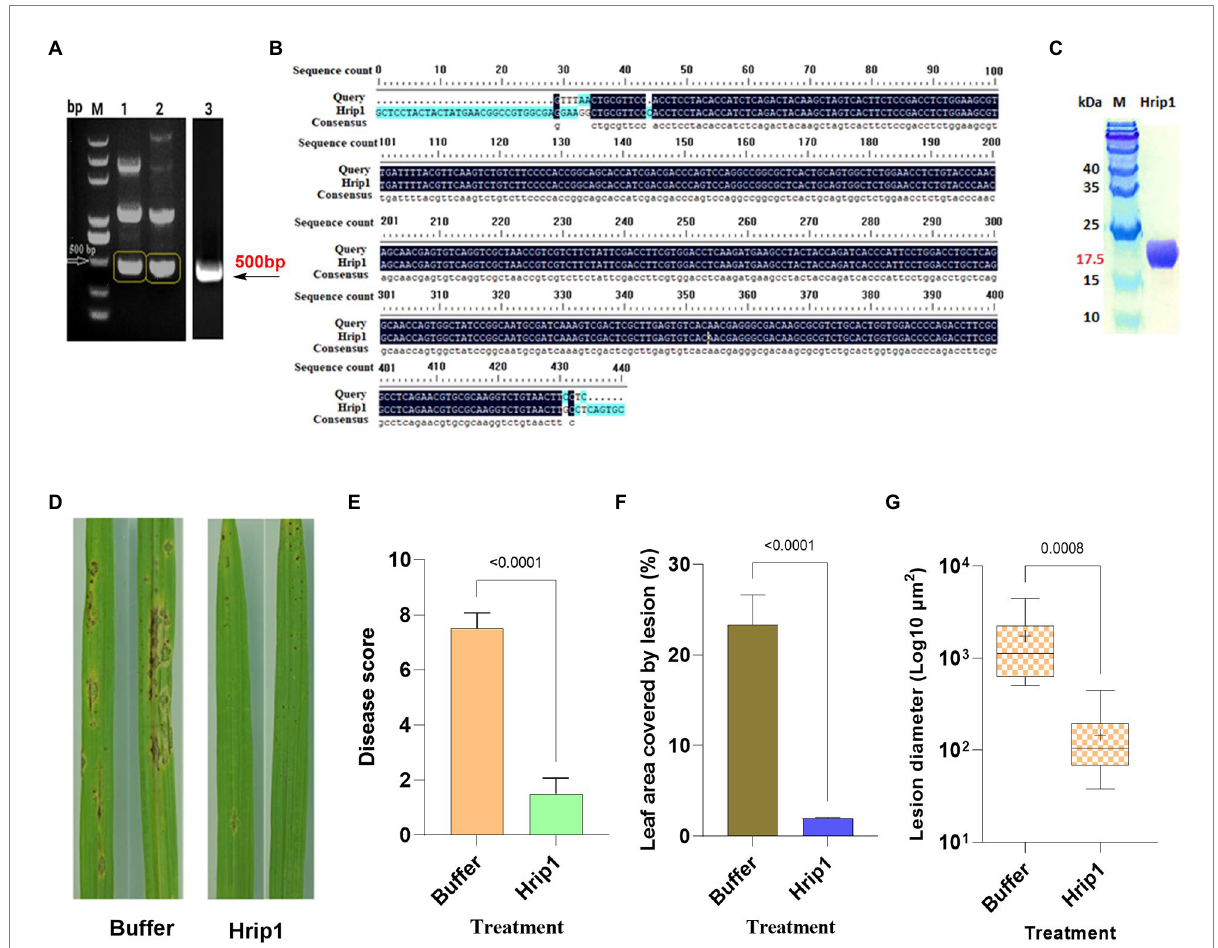
FIGURE 1 Protein expression and rice blast assay. (A) PCR amplified Hrip1 gene (500 bp). (B) Sequence alignment of Hrip1. (C) SDS-PAGE analysis of hrip1 protein (17 kDa). (D) Rice blast lesion features on leaves photographed after 7 days. (E) Rice blast scores ( n = 2). (F) Leaf surface area covered by lesion ( n = 2). (G) Mean diameter of lesions on the leaf ( n = 11, “+” denote mean). For all graphs, error bars = mean ± sd, compared at a 95% confidence